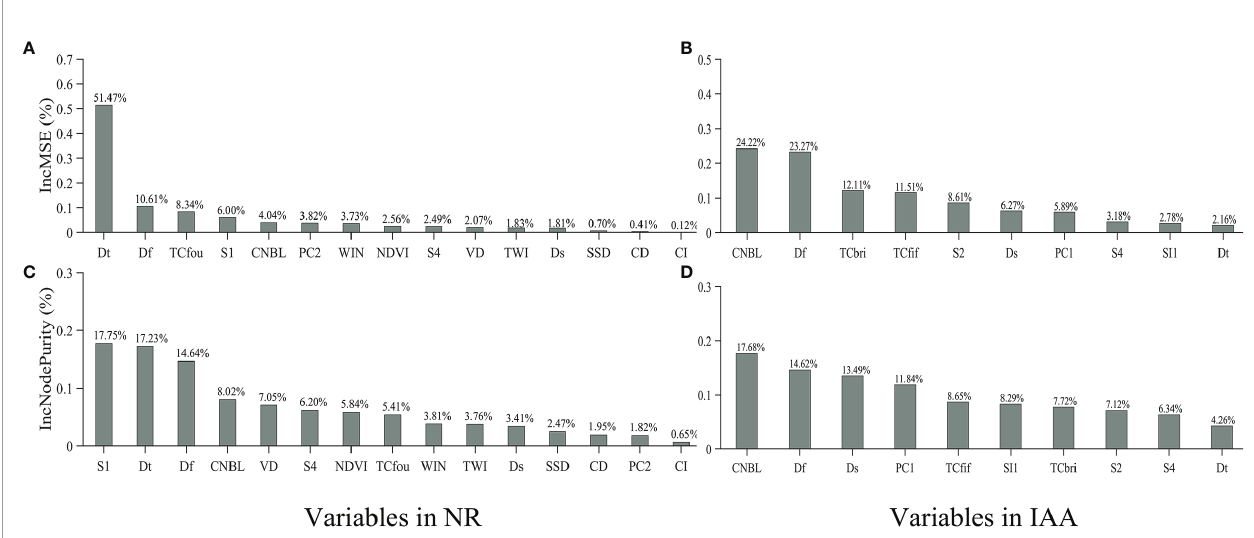
FIGURE 8 | Variable importance permutation of (A) the nature reserves (NR) by Inc.MSE, (B) the industrial and agricultural areas (IAA) by Inc.MSE, (C) the NR by Inc.NP, and (D) the IAA by